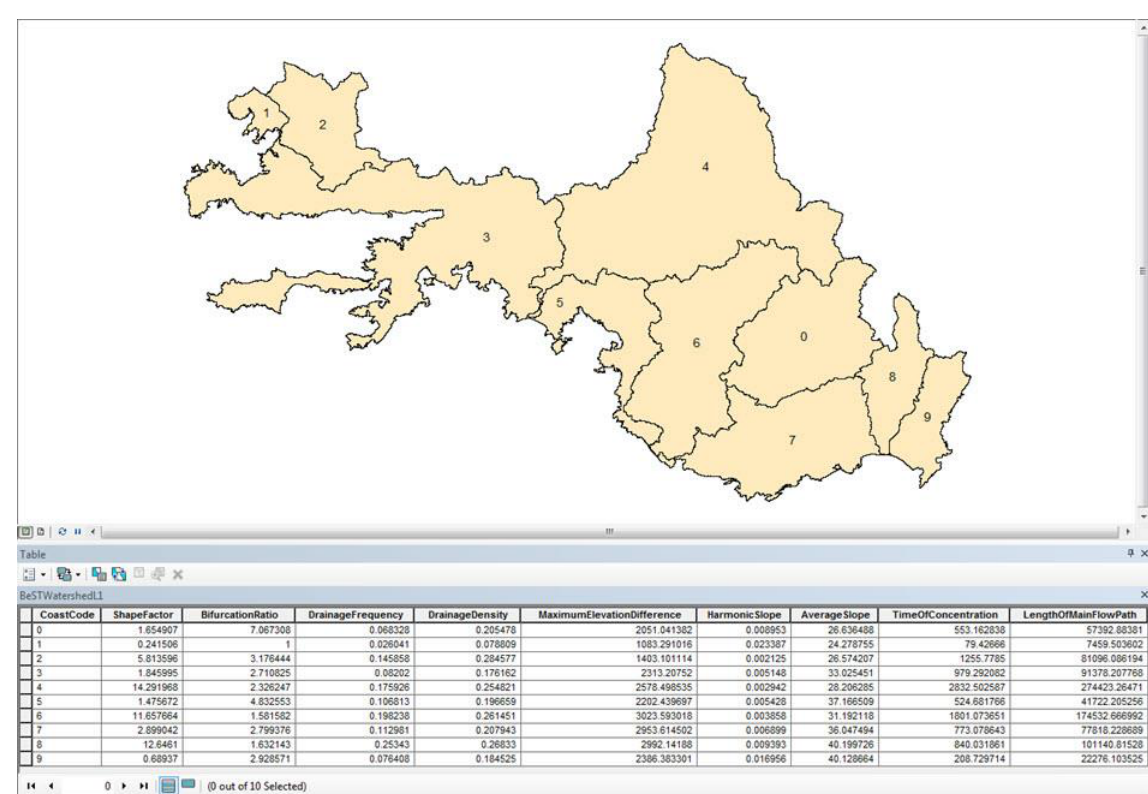
Figure 2. Sub-basins at first level of Western Mediterranean Basin and their topographic